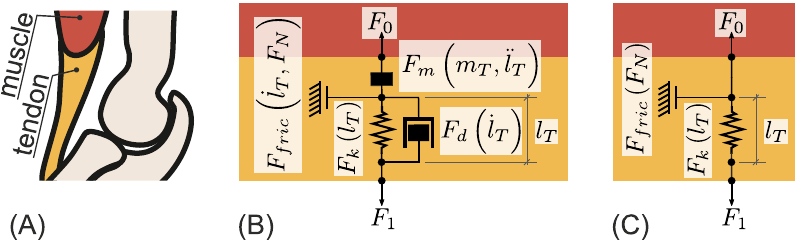
Fig 1. (A) Pictogram of the biceps brachii elbow flexor and its distal tendon with a mechanical model of the distal tendon in dynamic (B) and static conditions (C). (A) Pictogram of the biceps brachii (in red) and its lower tendon (in orange) attached to the radius . (B) A general tendon model including the tendon weight m ð _ l Þ , and friction to surrounding tissue F non linear damping F d T static conditions to the model shown in (B).